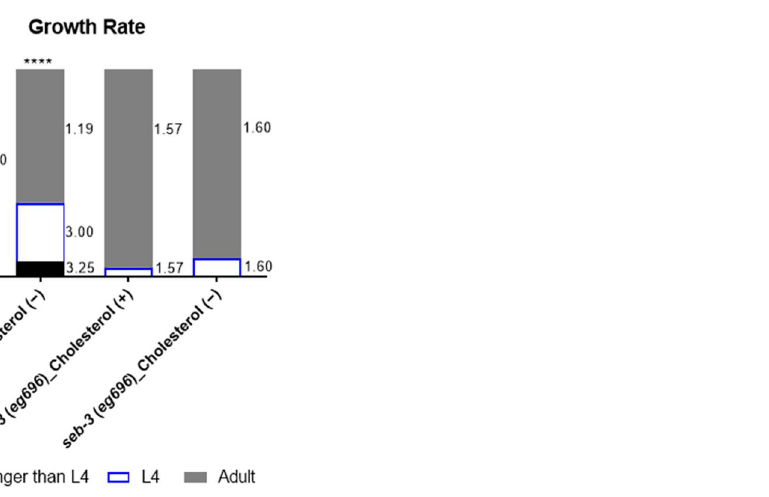
Figure 4. Cholesterol depletion altered developmental rates in WT C. elegans . The cholesterol depletion culture condition is demonstrated as the delayed growth rate that the WT animals should have shown. The number of animals in each developmental stage, after four days in embryos that were synchronized to the stage of birth for 1 h, is shown (younger than L4 stage, L4 stage, and adult). A total of 428 (WT-Chol_Fed), 628 (WT-Chol-depleted), 205 ( seb-3 -Chol_fed), and 189 ( seb-3 -Chol_depleted) worms from four replicates of biological samples were analyzed to obtain the average growth rate (%). The delayed growth-rate effect of cholesterol depletion was suppressed in the seb-3(eg696) variants. A chi-square test indicated **** p <0.0001. Error shown to the right of each section of the bar graph is SEM.